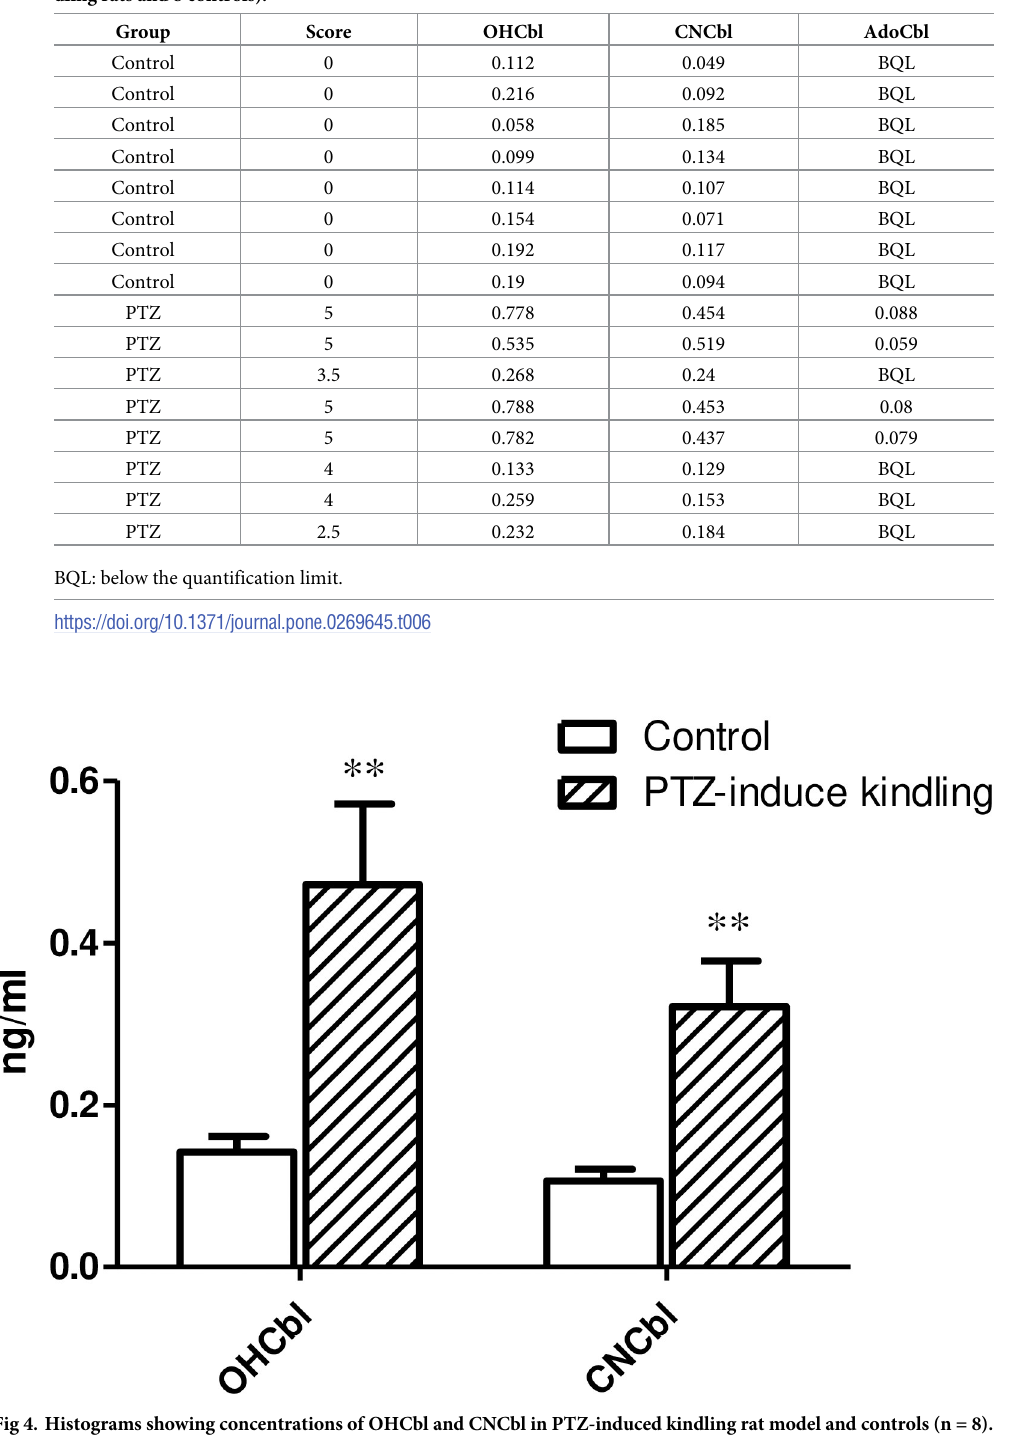
Table 6. Plasma OHCbl, CNCbl and AdoCbl concentrations (ng/ml) and scores in rat model (8 PTZ-induced kin- dling rats and 8 controls).